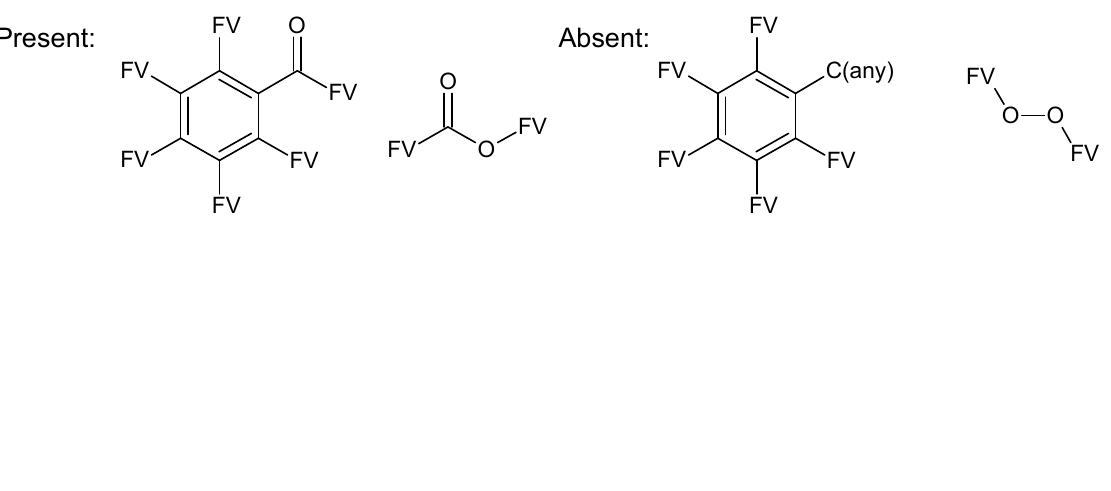
Figure A1. Substructures for GC–MS Challenge 1. FV = free